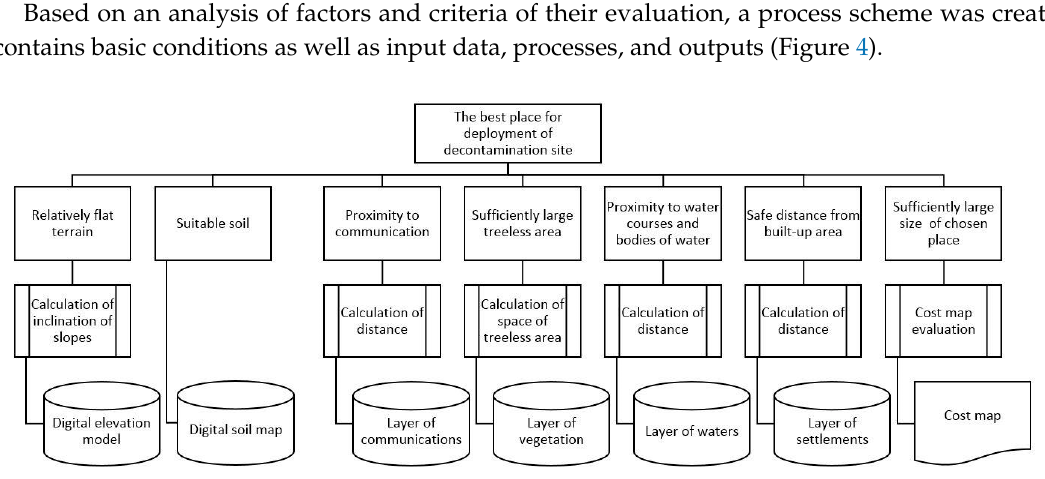
Table 2. Weights of factors and evaluation criteria.